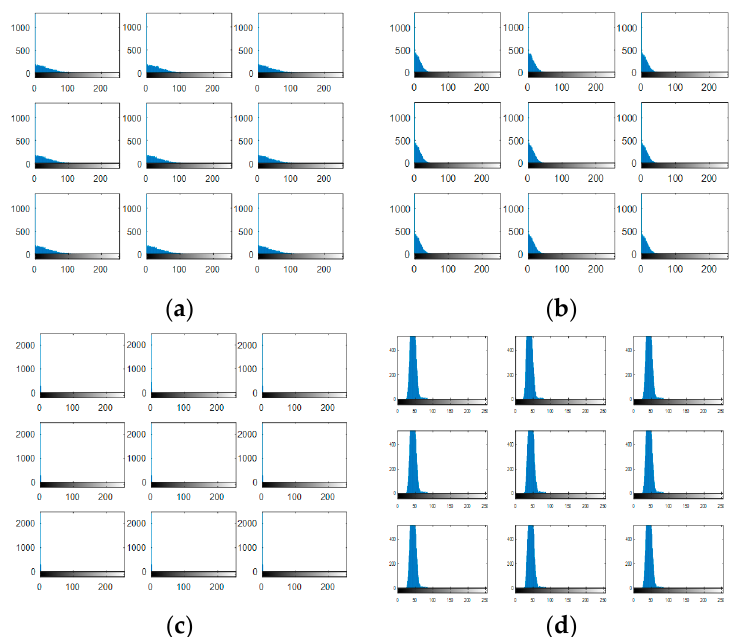
Figure 8. Histograms of encrypted images based on combinations in Figure 6, i.e., ( a ) CFR1, ( b ) CFR2, ( c ) homomorphic transform followed by salting and ( d ) homomorphic transform followed by random kernel convolution. Table 1. Evaluation of CFR frameworks based on ORL dataset.